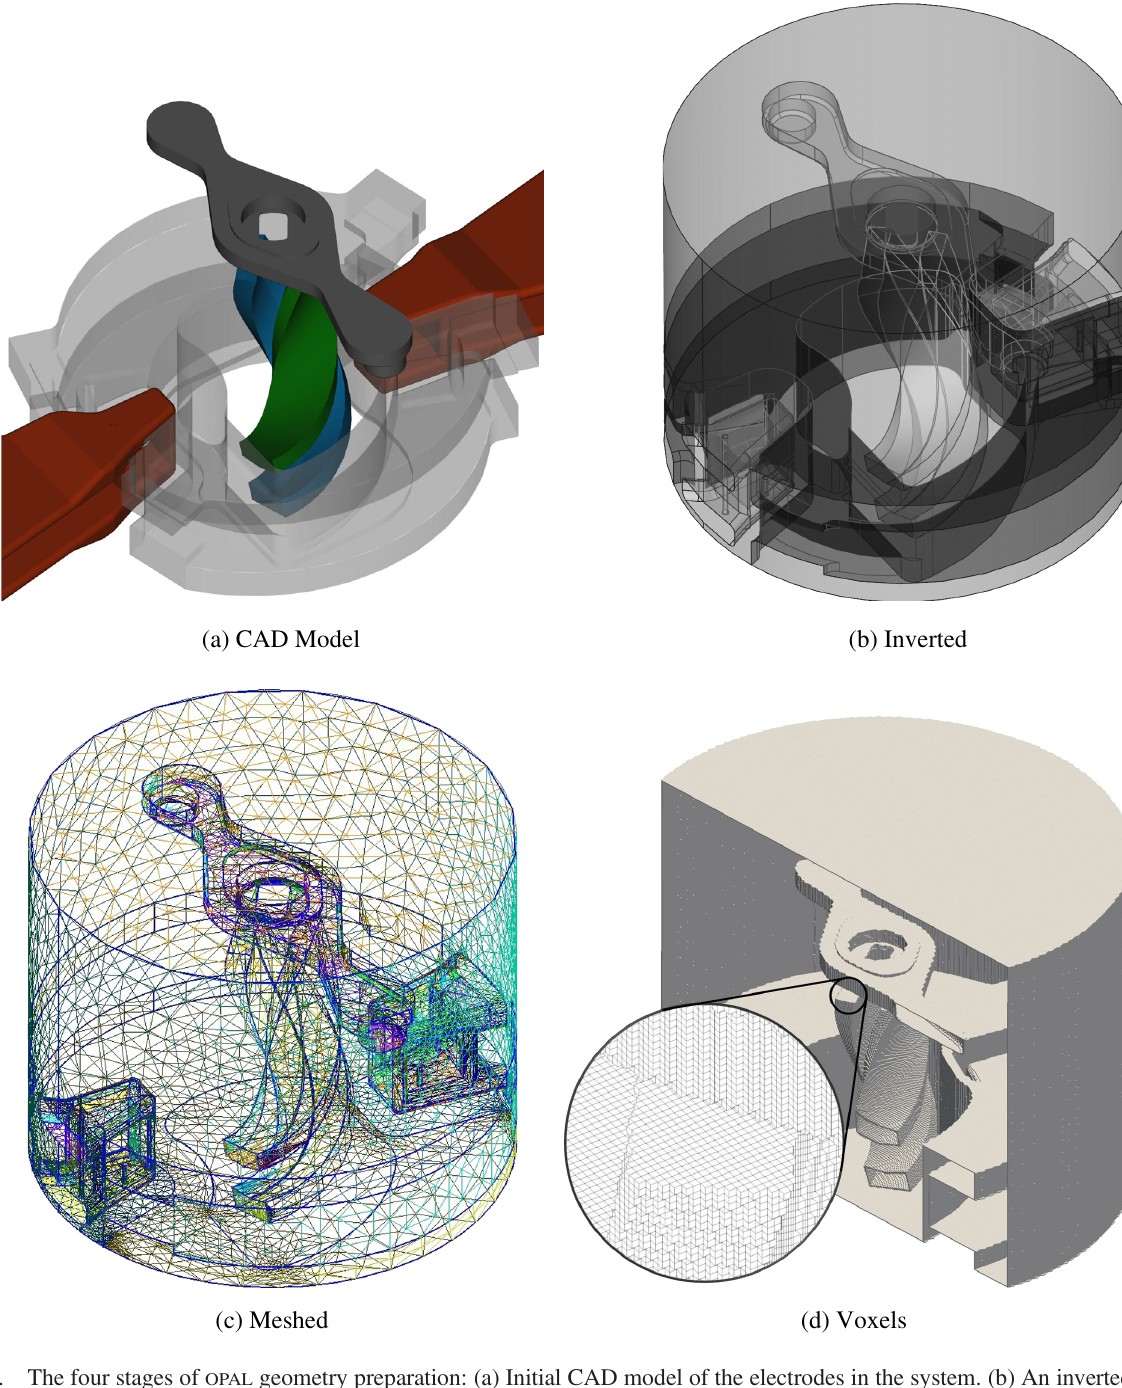
FIG. 3. The four stages of OPAL geometry preparation: (a) Initial CAD model of the electrodes in the system. (b) An inverted solid is created by subtraction of all elements in (a) from a “ master volume ” (in this case a cylindrical chamber). (c) The inverted geometry is saved in stp format and a mesh is generated using GMSH [14]. (d) During initialization, OPAL creates a voxel mesh to speed up the tests that have to be performed every time-step (cf.